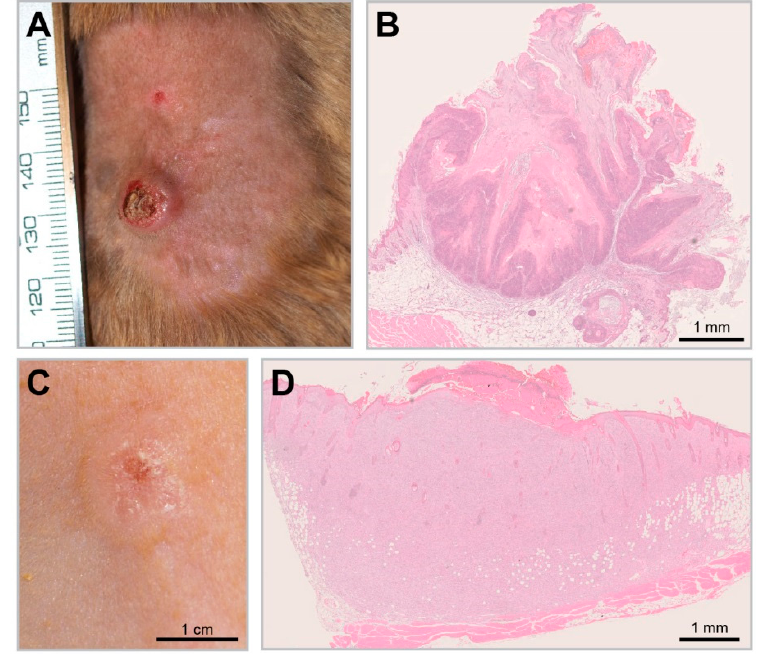
Figure 6. UV-induced SCCs in the Mastomys model. ( A ) A UV-induced KSCC. ( B ) KSCCs are characterized by the growth of well-differentiated squamous cells and show strong keratinization comparable to spontaneous MnPV-induced tumors (HE staining). ( C ) A UV-induced nKSCC. ( D ) HE staining of a poorly differentiated nKSCC.